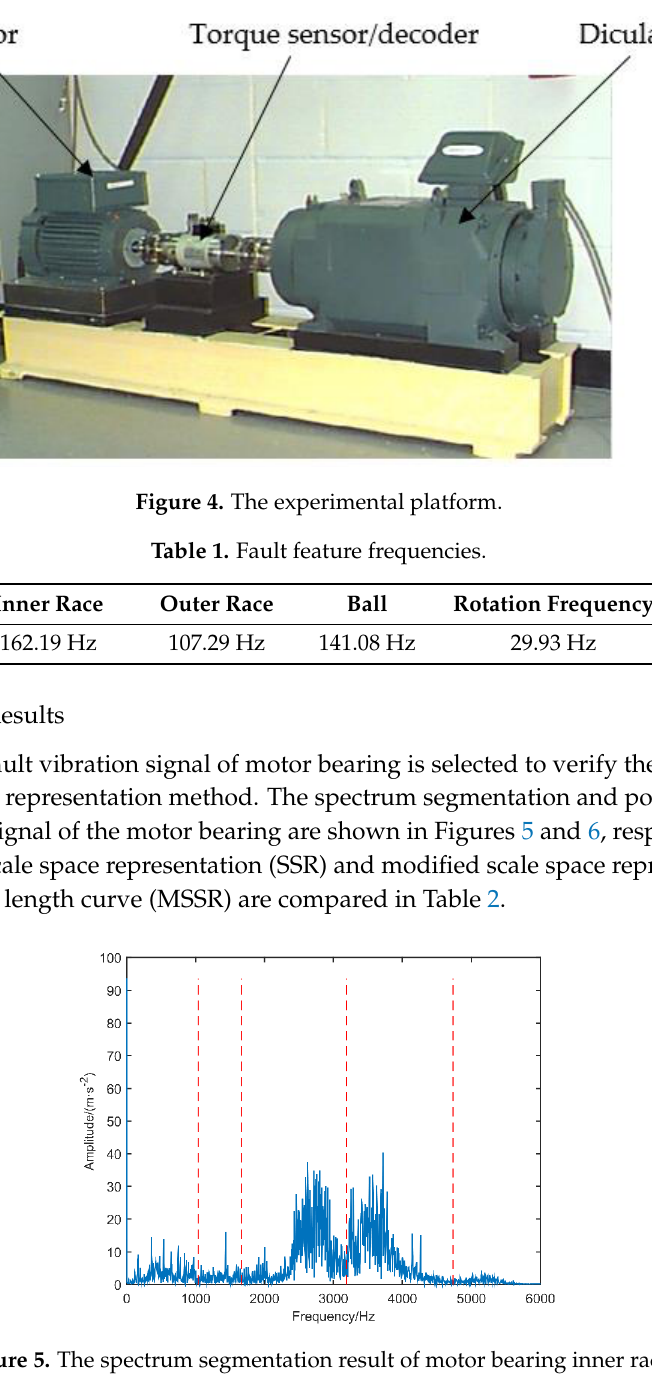
Table 1. Fault feature frequencies.